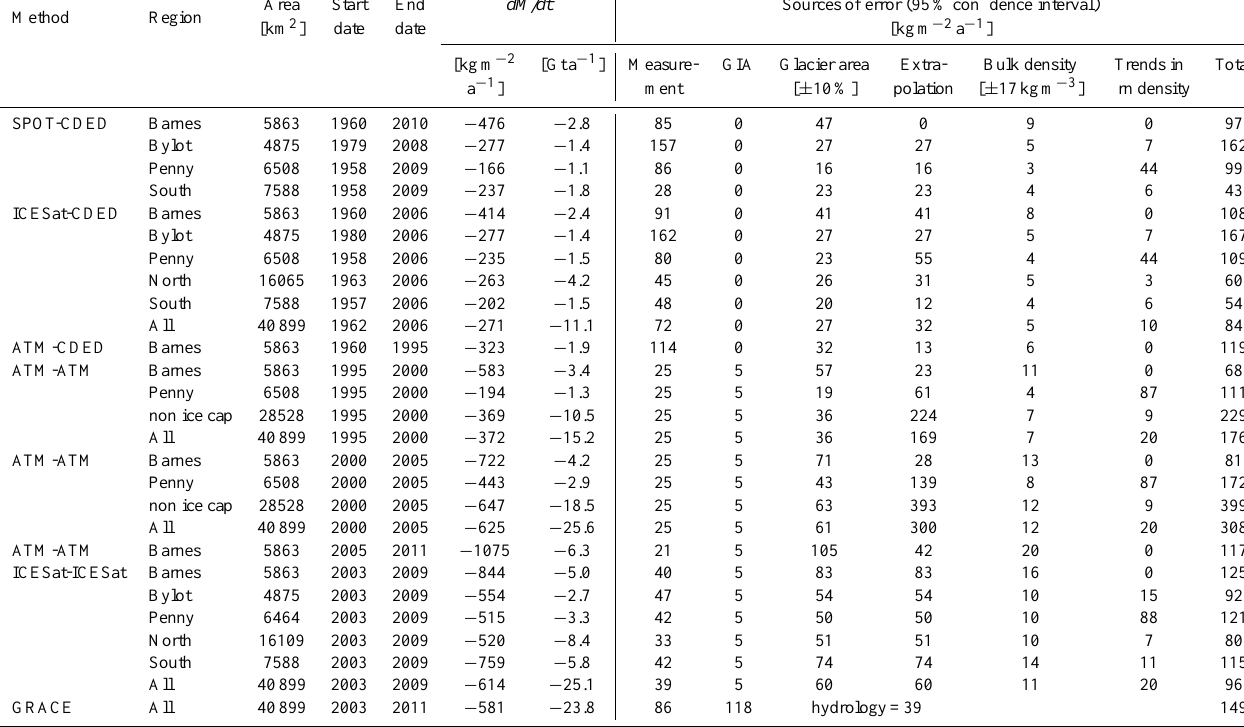
Table 1. Glacier mass change determined from CDED, SPOT, ICESat and ATM elevation data sets with respective uncertainties. Method Region